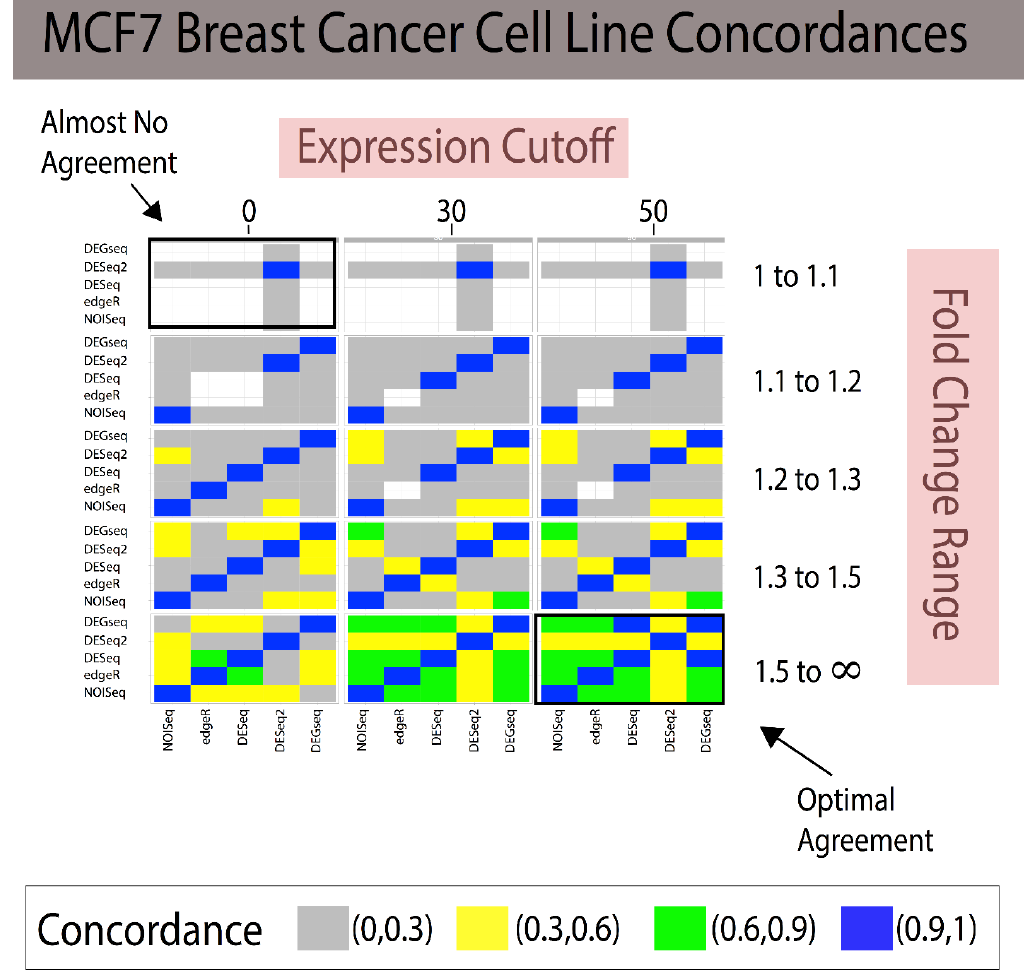
Figure 2. Combining fold change and expression level filtering leads to robust, method-agnostic reference standards for single-subject studies in breast cancer. The grid of heatmaps illustrates that as low-expression genes with small fold changes across individuals are filtered out, the reference standards constructed agree increasingly more with one another. In the bottom right, most methods attain a 100% concordance with one another, providing a reliable gold standard. Expression cutoffs are applied to genes whose average counts across samples fall under the threshold. White cells indicate that no predictions were made, and therefore the Jaccard Index cannot be calculated. Note: When the JI cannot be calculated due to the lack of transcripts, the color of the rectangle is white; in addition, FC ranges are symmetric 1/1.1 to 1 and 1 to 1.1, 1/1.2 to 1 and 1 to 1.2, etc. (Legend: In the manuscript and figure, we represent FC for upregulated genes and 1/FC for downregulated genes.”).